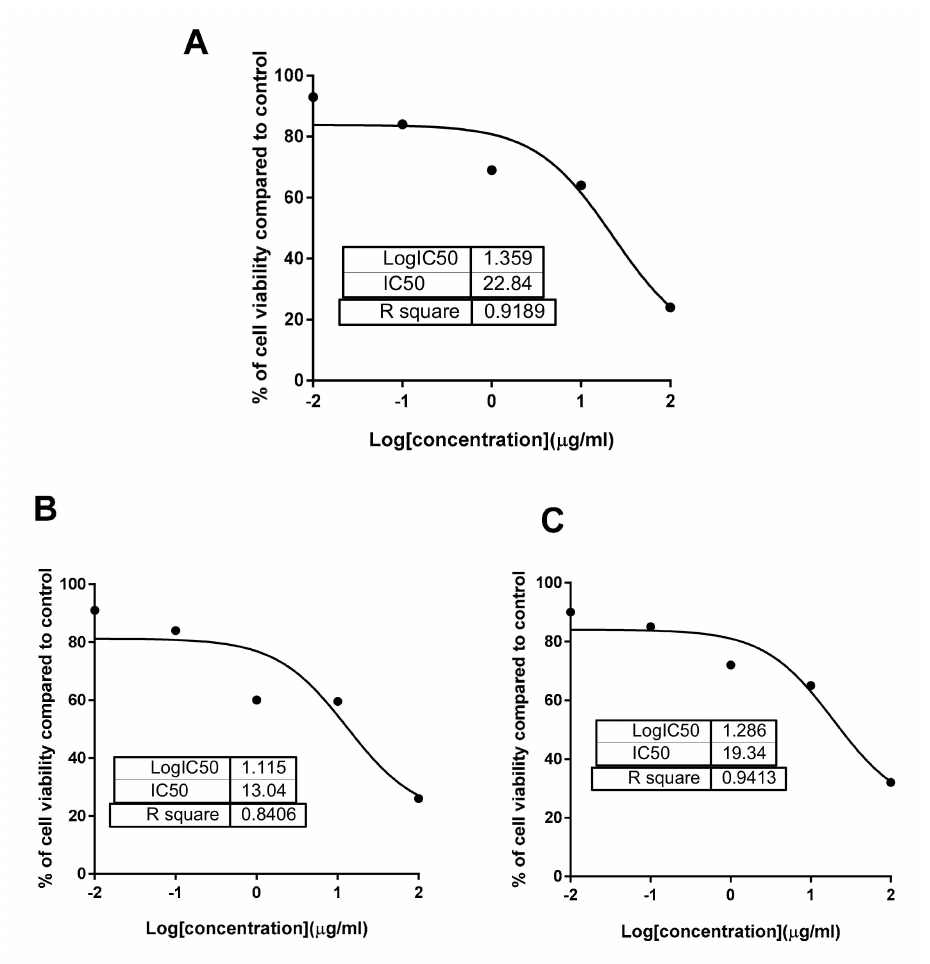
Figure 5. IC 50 nonlinear regression curve fit of percentage of cell viability vs log [con. µ g / mL], R square ≈ 1, using the GraphPad prism software. ( A ) Cytotoxicity of crude extract against MCF–7, ( B ) Cytotoxicity of phenolics extract against MCF–7, ( C ) Cytotoxicity of phenolics extract against